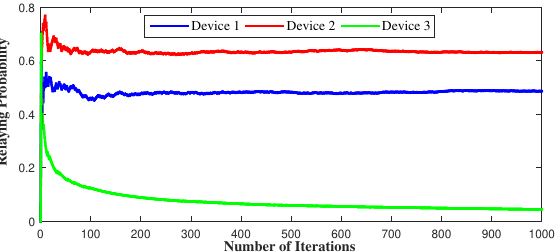
Figure 8. The effect of channel fading on the convergence to a mixed NE using BG dynamics. Figures 9 and 10 depict the behavior of the devices using the BG algorithm function of γ th and x i . Differently from Figure 8 where γ th = 40 dB and x i = 0.5, i ∈ { 1, 2, 3 } , the algorithm converges to partially mixed equilibria. For γ th = 30 dB, device 1 decides